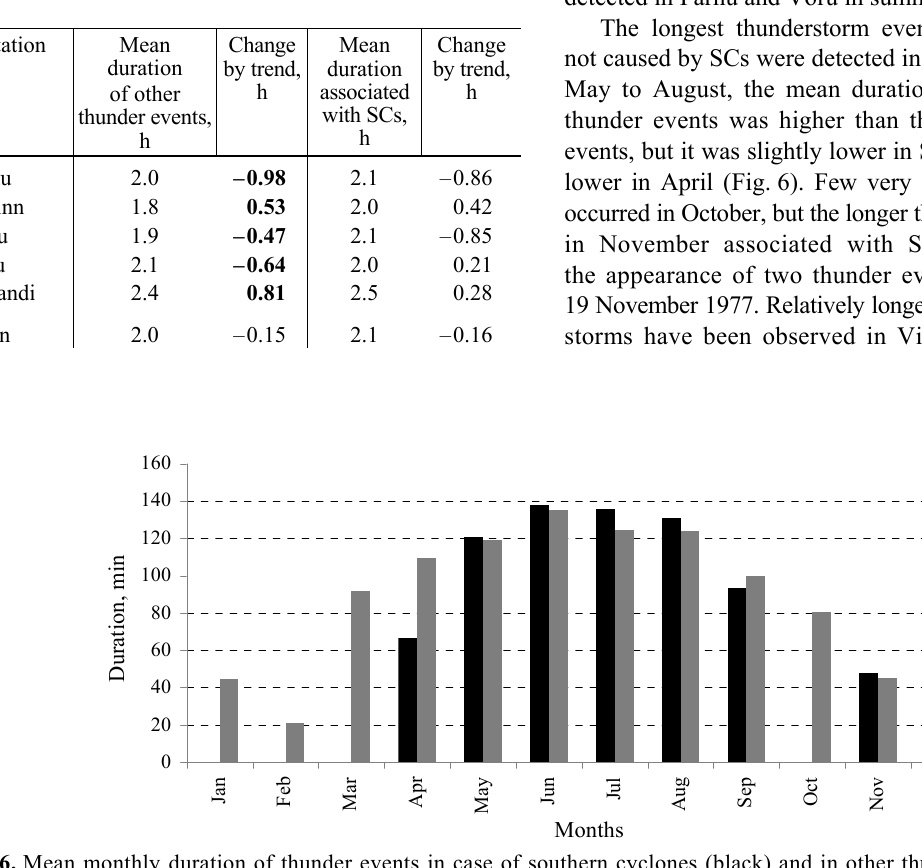
Table 3. Average duration and change by trend of other thunder events and southern cyclones-associated thunderstorms at five meteorological stations in Estonia during 1950(cid:150)2010.